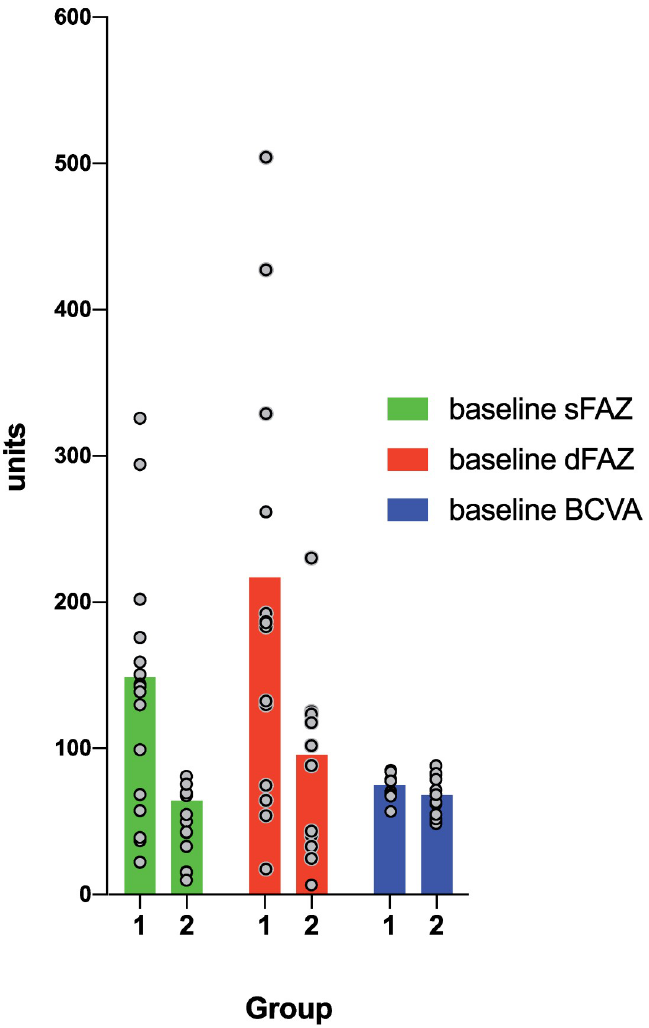
Fig 3. Parameters correlating with ERM severity. Data shows mean baseline sFAZ area, dFAZ area, BCVA, which show significant correlations with ERM severity (Group 1 = ERM stages 1 and 2; Group 2 = ERM stages 3 and 4). The y-axis units refer to the appropriate measures of the before-mentioned variables (sFAZ and dFAZ area: μ m 2 , BCVA: ETDRS letters). Grey dots represent individual values; note that some lay on top of each other. Data are presented as mean; sFAZ = superficial retinal plexus area; dFAZ = deep retinal plexus area; BCVA = best corrected visual acuity.